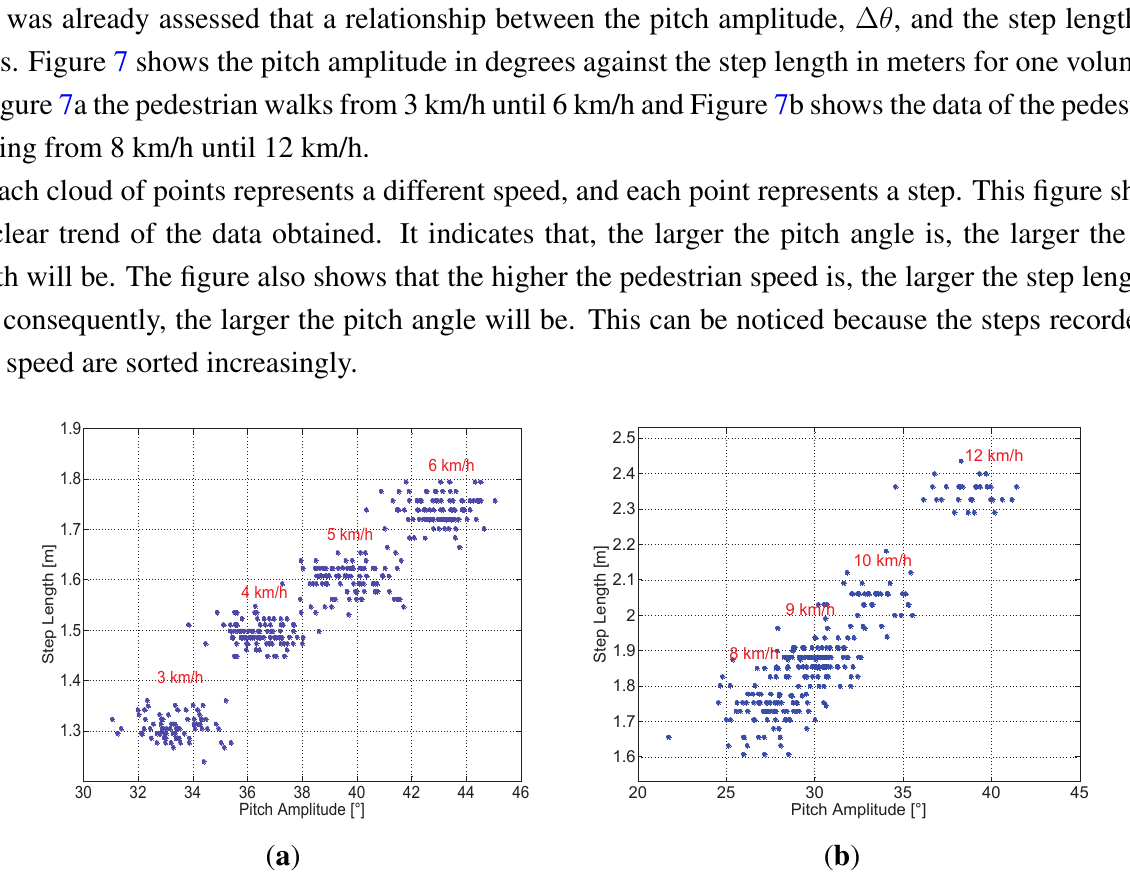
Figure 7. The points represent the steps from one volunteer. Each cloud of points represents a different speed. ( a ) when he was walking; ( b ) when he was